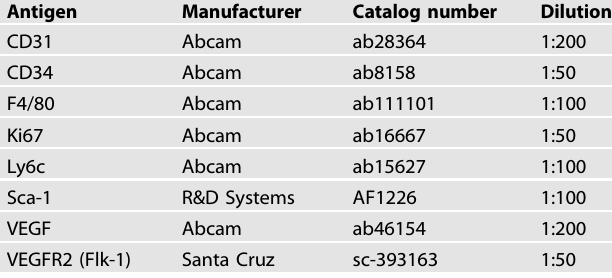
Table 1. Antibodies used in this